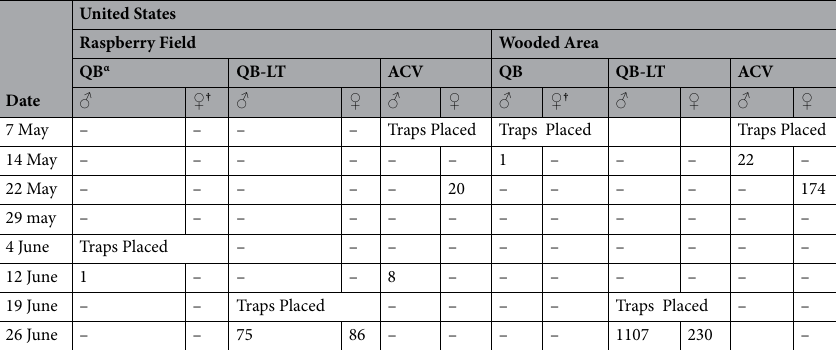
male compared to the ACV trapping eight SWD males. Liquid traps baited with QB were placed on June 19, 2019 and immediately captured SWD males and females during the first week of trapping. Comparison of QB baited dry sticky traps in France, Germany, Italy, and Spain. A comparison of the QB baited dry sticky traps average SWD captures and selectivity from France, Germany, Italy, and Spain